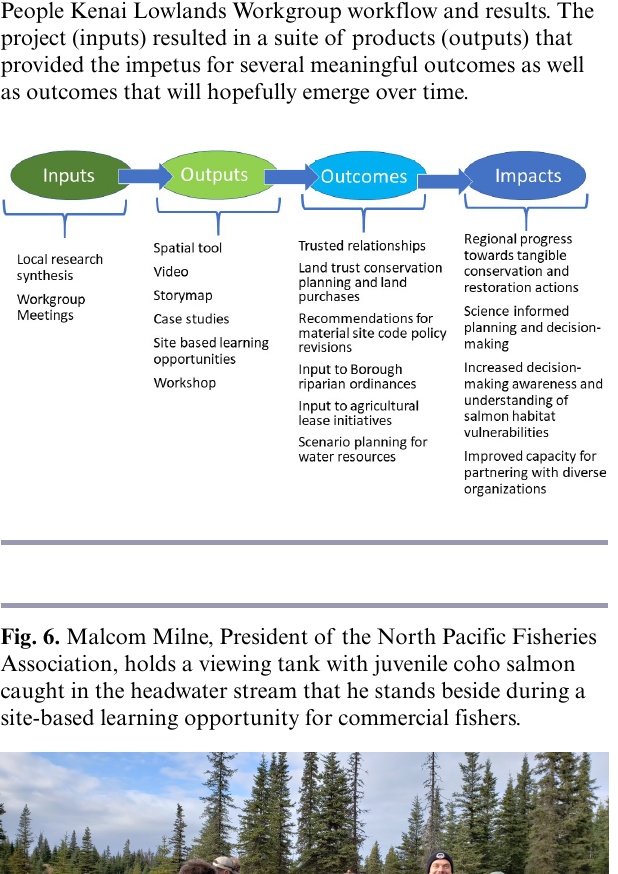
Fig. 5. Flowchart showing the State of Alaska Salmon and People Kenai Lowlands Workgroup workflow and results. The project (inputs) resulted in a suite of products (outputs) that provided the impetus for several meaningful outcomes as well as outcomes that will hopefully emerge over time.